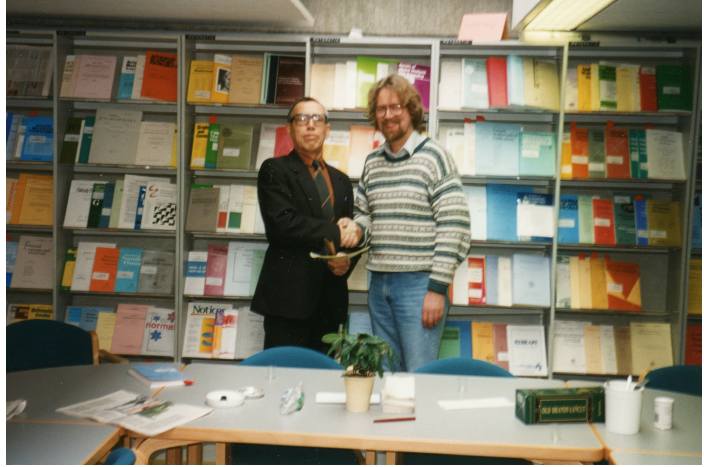
Figure 8: Vadim Vizing and Bjarne Toft at the University of Odense (now Southern Denmark), 1995. In 1999, I visited Akademgorodok in Siberia, taking part in a fantastic meeting which Vizing (and many others)